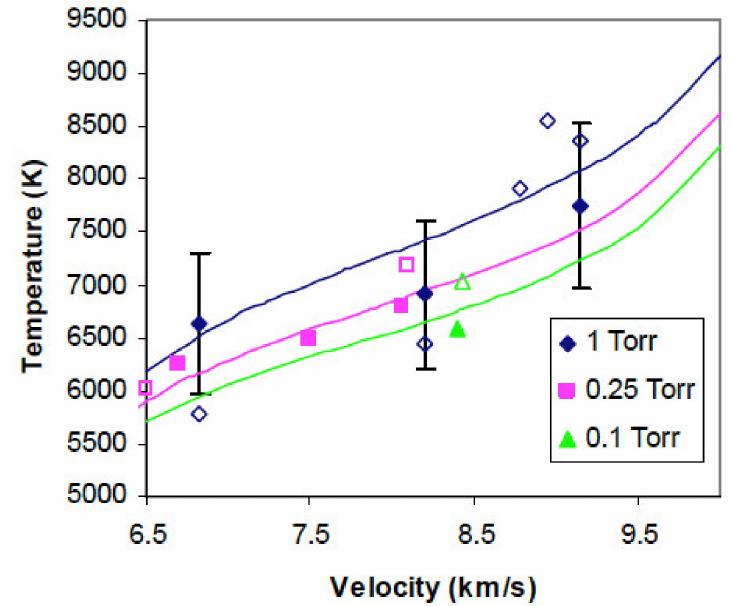
Figure 11. Rotational temperature for Venus and Mars conditions